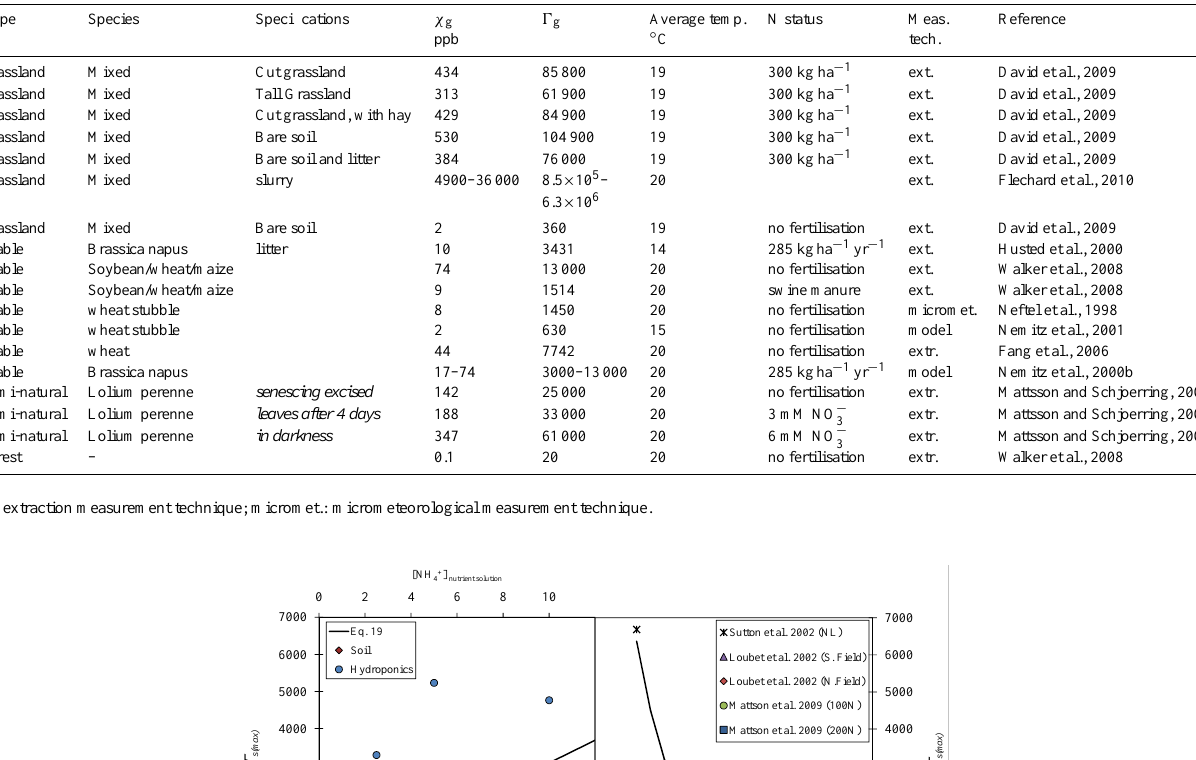
Table 4. Compiled data of 0 g values.